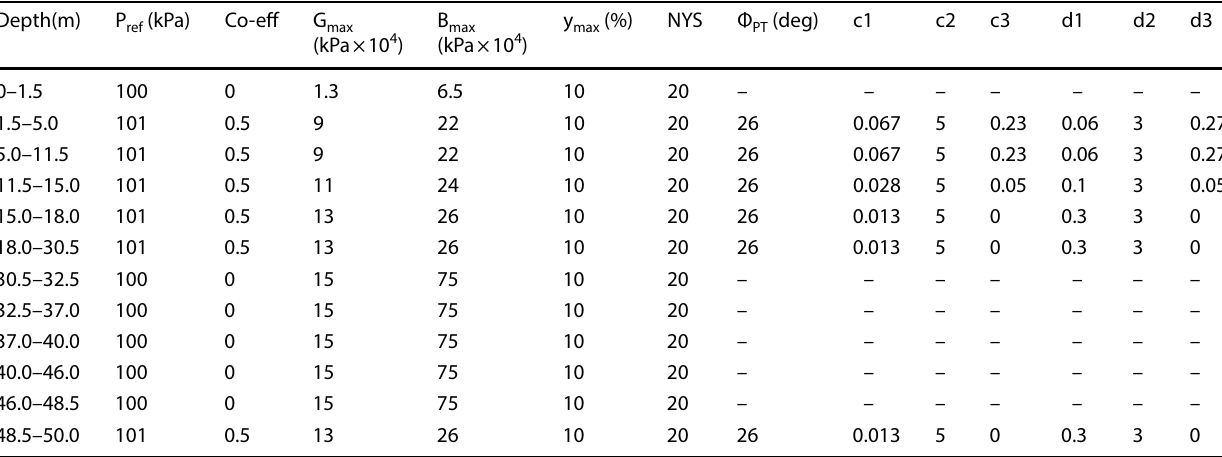
Table 6 Values of model parameters for RCD soil of Tollygunge Metro site Depth(m) P ref